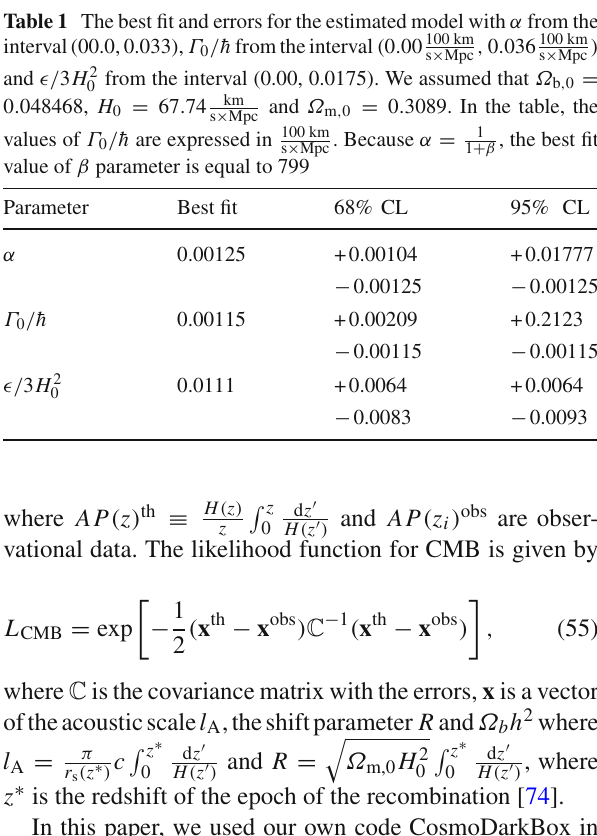
Fig. 6 A diagram presents a dependence T end rad.dec. (β) given by Eq. (49) for β > 29. For illustration we put the best fit value of Γ 0 (see Table 1). The values of T end rad.dec. are expressed in terms of the present age of the Universe T 0